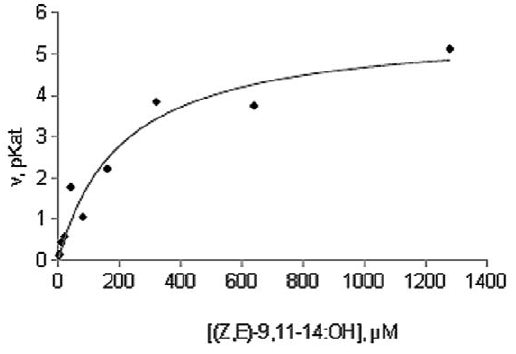
Figure 2. Plot of reaction velocity of Acinetobacter wax synthase vs substrate ( (Z,E) -9,11-tetradecadienol) concentration (1.25 m M–1.3 mM) giving in batch a Michaelis-Menten profile. doi:10.1371/journal.pone.0047751.g002 PLOS ONE |